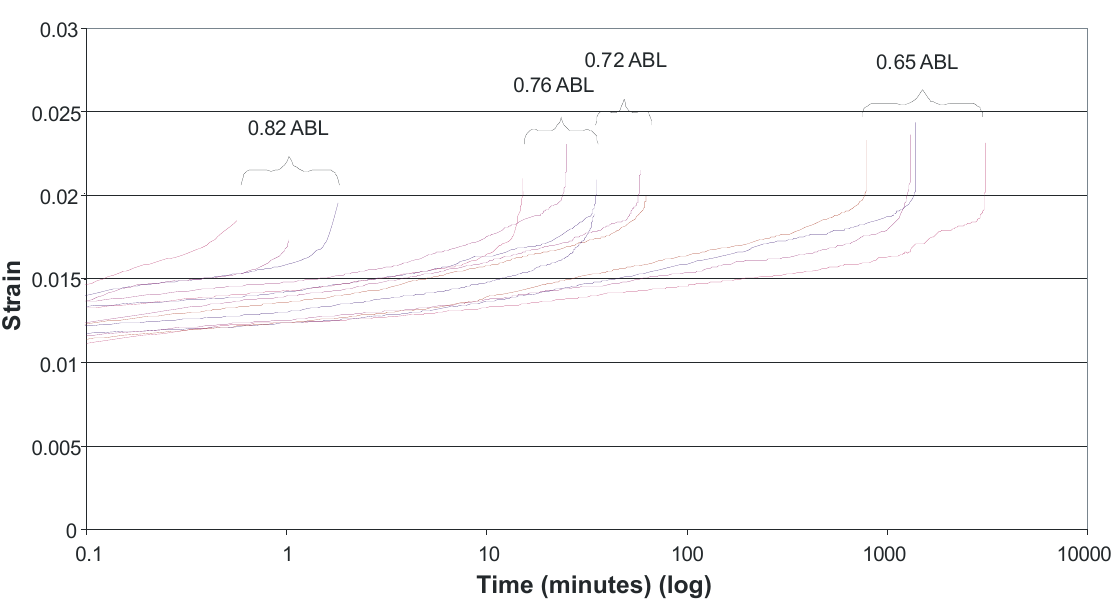
Figure 10. Creep strain curves – all tests on log time